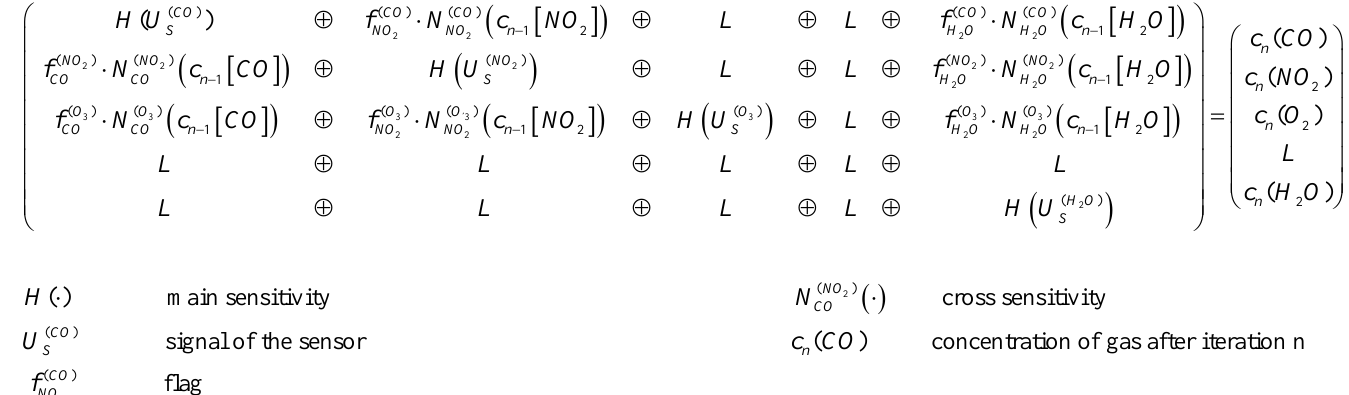
Figure 2. Sensor matrix for signal evaluation [8]. The main gas concentrations H are calculated from the sensor signals U and the cross-functionalities N are gas concentrations from previous iteration s